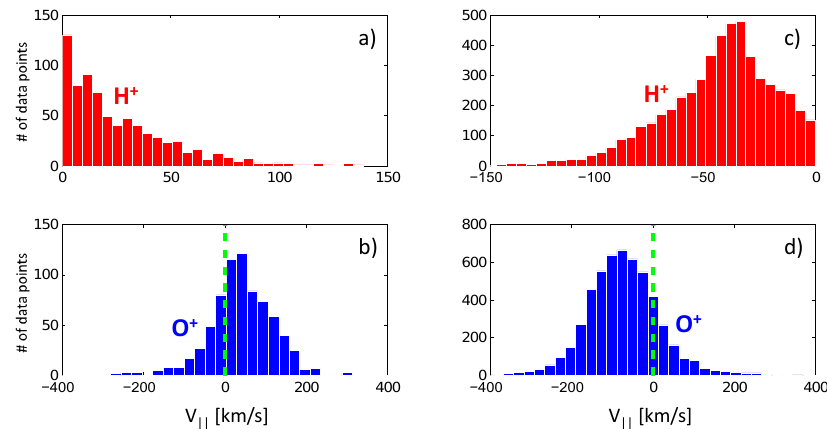
Figure 4. The occurrences of H + and O + parallel bulk velocities for northward IMF for small clock angles, | θ | < 30 ◦ . Panels (a) and (b) show data when H + flows towards the equatorial plane, v (cid:107) (H + ) > 0, with H + and O + represented by red and blue bars respectively. Panels (c) and (d) show data for when H + flows away from the equatorial plane, v (cid:107) (H + ) < 0.